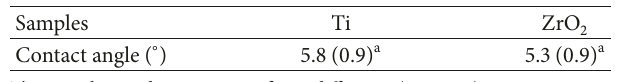
Table 2: Time at which frequency began to decrease (mean ± SD 𝑛 = 3